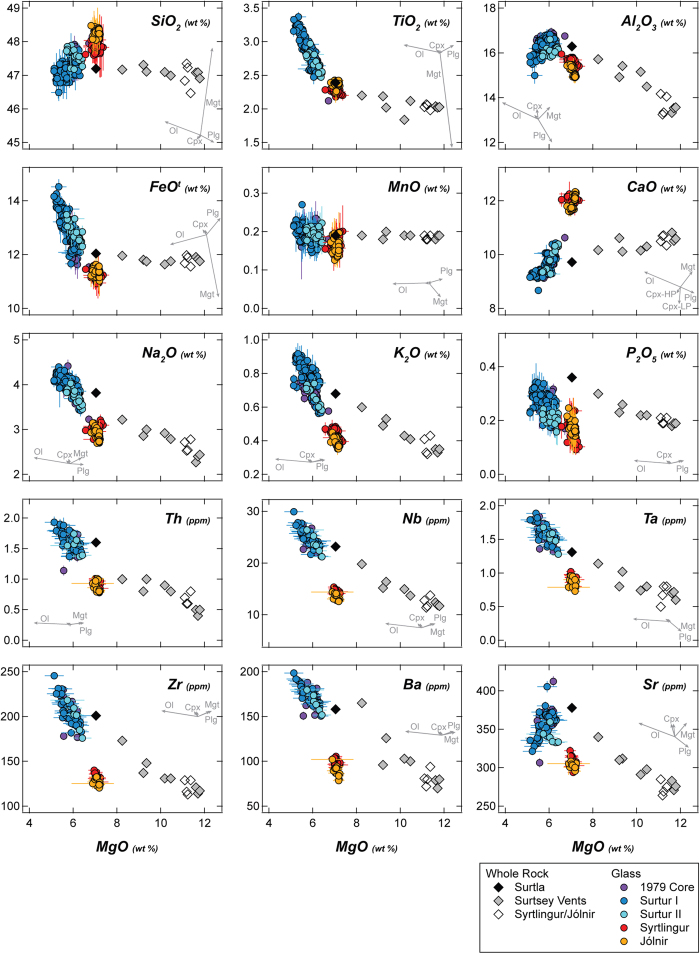
Major and selected trace-element variation diagrams versus MgO.Black arrow shows fractionation trend (~26% Olivine (Ol) + 21% Plagioclase (Plag) + 47% clinopyroxene (Cpx) + 6% magnetite (Mgt); calculated mineral compositions) modelled by Furman et al.27. Grey arrows show direction and magnitude for 5% fractionation of different phases. Major elements modelled using measured Surtsey olivine, plagioclase (Table S1), and oxide26 compositions, and compositions of clinopyroxene formed in high- (HP) and low pressure (LP) experiments22. Note that for all but CaO, the distinction between HP and LP Cpx is trivial. Trace elements modelled using standard distribution coefficients compiled in Rollinson36.